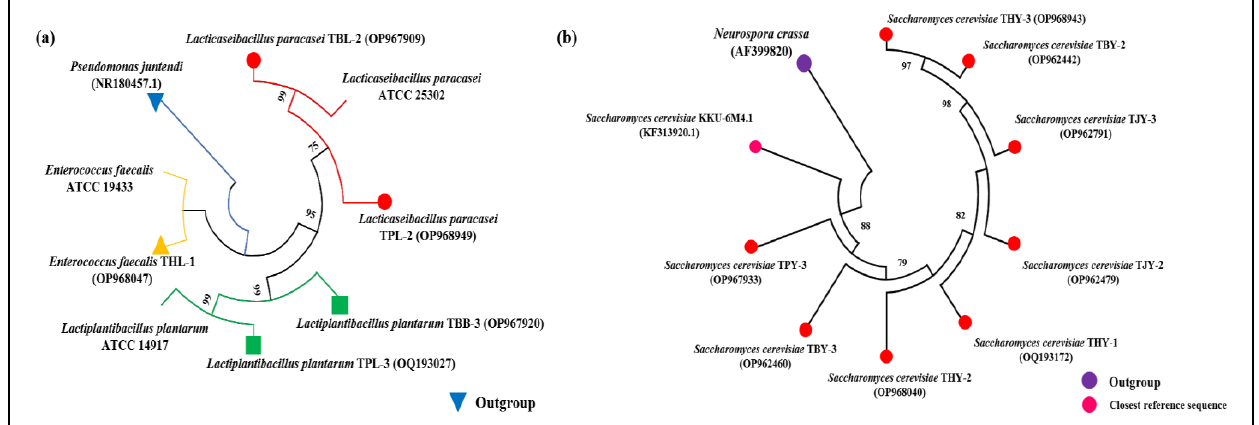
Figure 2. Successional changes in total microbial load and different physico-chemical parameters during the fermentation of toddy : ( a ) total bacterial load, ( b ) total load of yeasts, ( c ) pH, ( d ) total acidity content and ( e ) total alcohol content (error bar is representing SD).